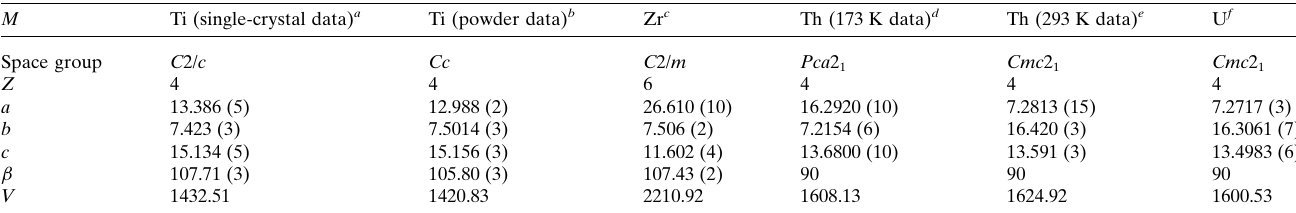
Table 1 Crystal data (A˚ , (cid:3) ) of Cs 2 M IV Si 6 O 15 compounds. M